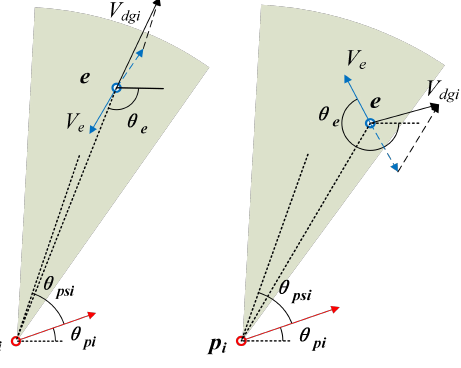
Figure 5. Damage range and movement diagram of the